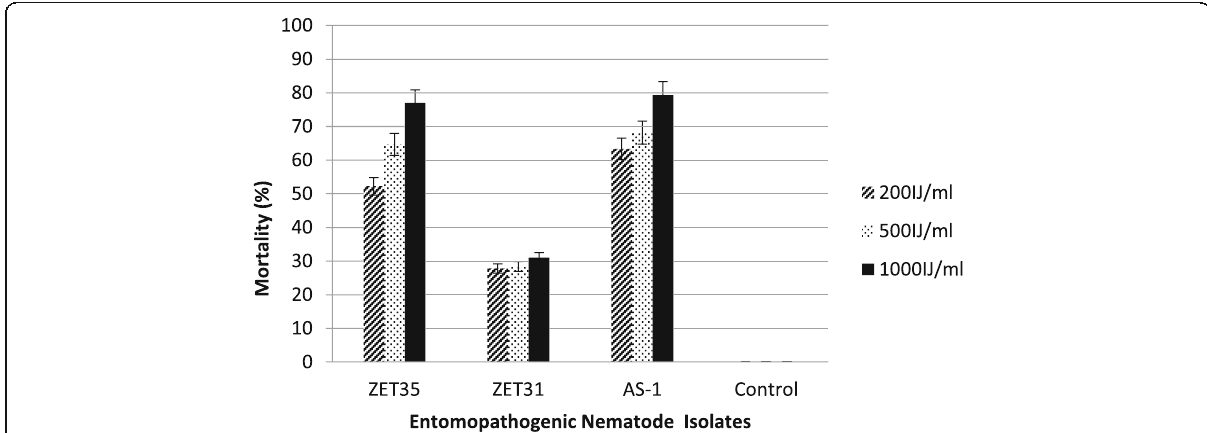
Fig. 1 Efficacy of H. bacteriophora (ZET35), S. feltiae (ZET31), and S. websteri (AS-1) on pre-pupae of A. alni at 25